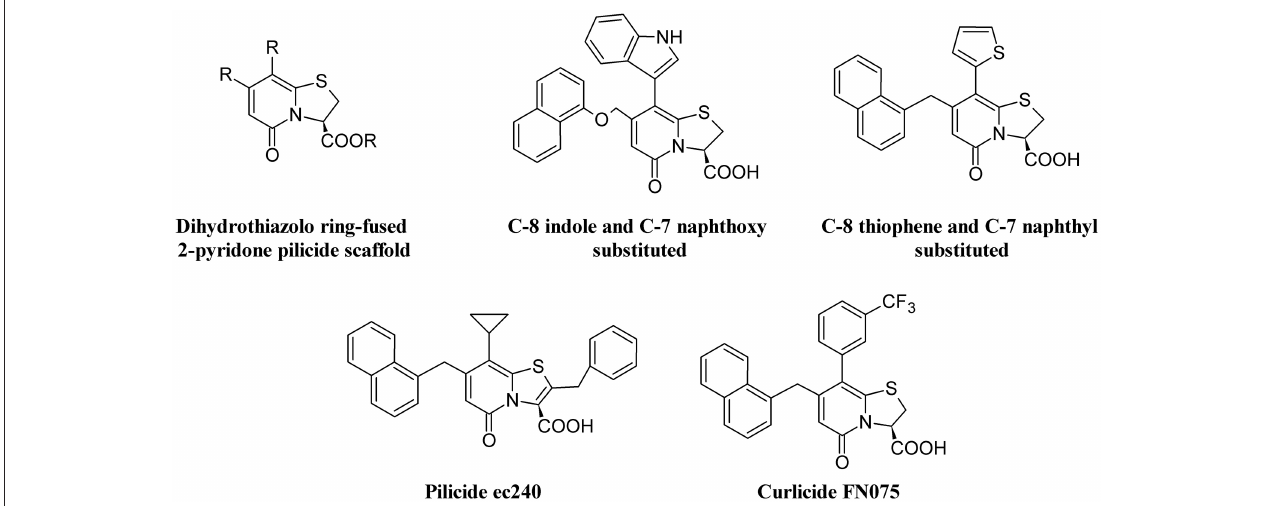
FIGURE 5 | Structure formulae of pilicide scaffold, some bioactive pilicides, and the curlicide FN075.